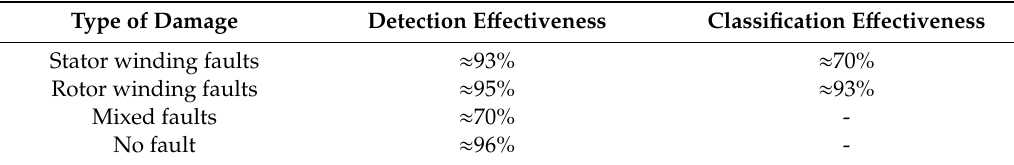
Table 1. E ff ectiveness of the IM winding fault detection and classification using SOM.